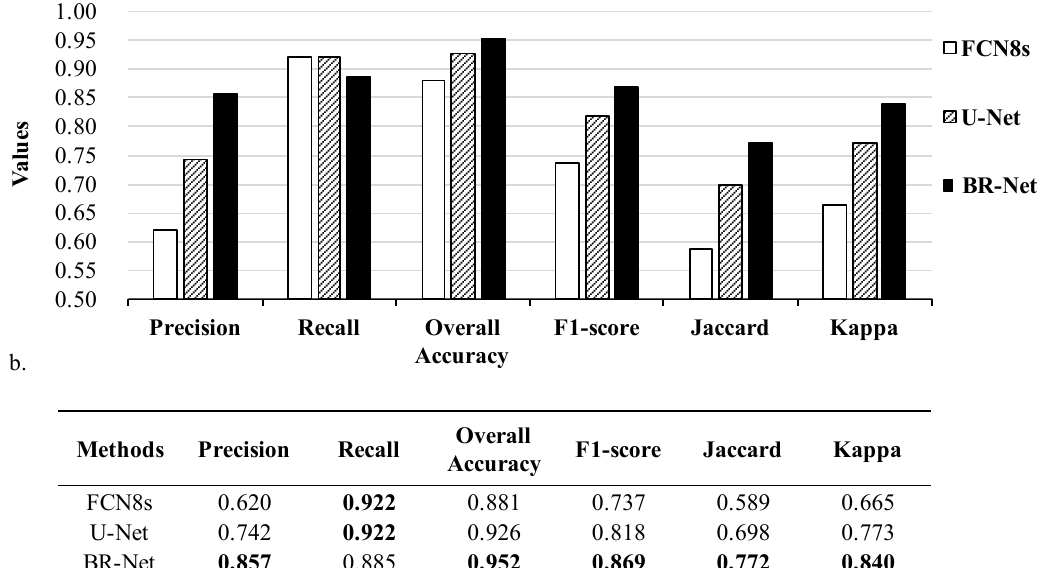
Figure 10. Comparison of segmentation performances of FCN8s, U-Net, and BR-Net across the entire testing area. ( a ) Bar chart for performance comparison. The x- and y-axis represent the evaluation metrics and corresponding values, respectively. ( b ) Table of performance comparisons of methods. For each evaluation metric, the highest values are highlighted in bold